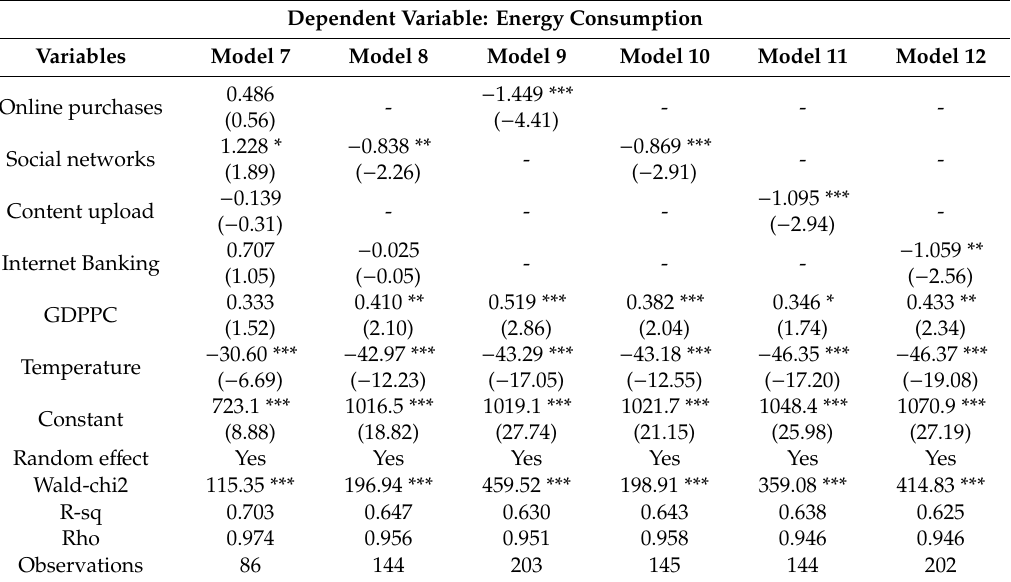
Table 7. Panel regression for the variables in group